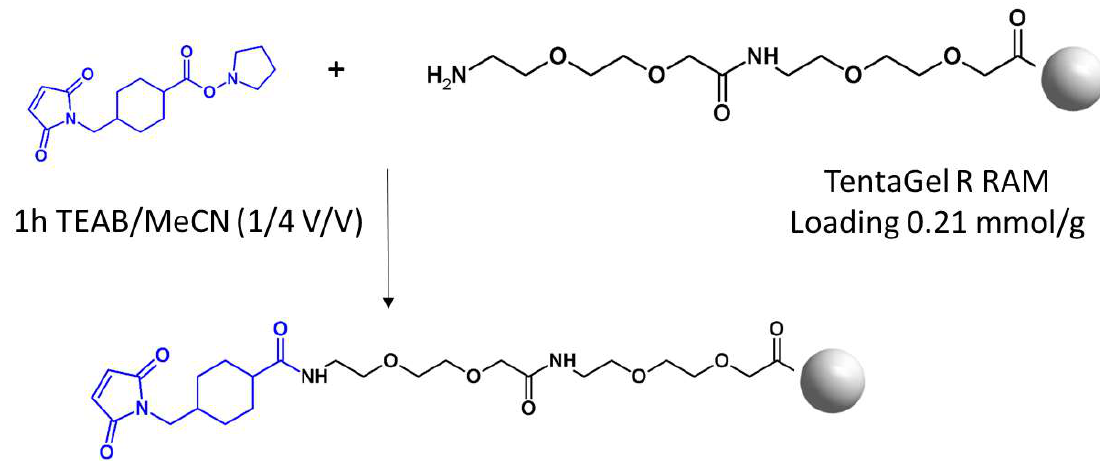
Figure 1. Schematic presentation of the preparation of modified TentaGel R RAM resin for selective capture of cysteine-containing peptides.